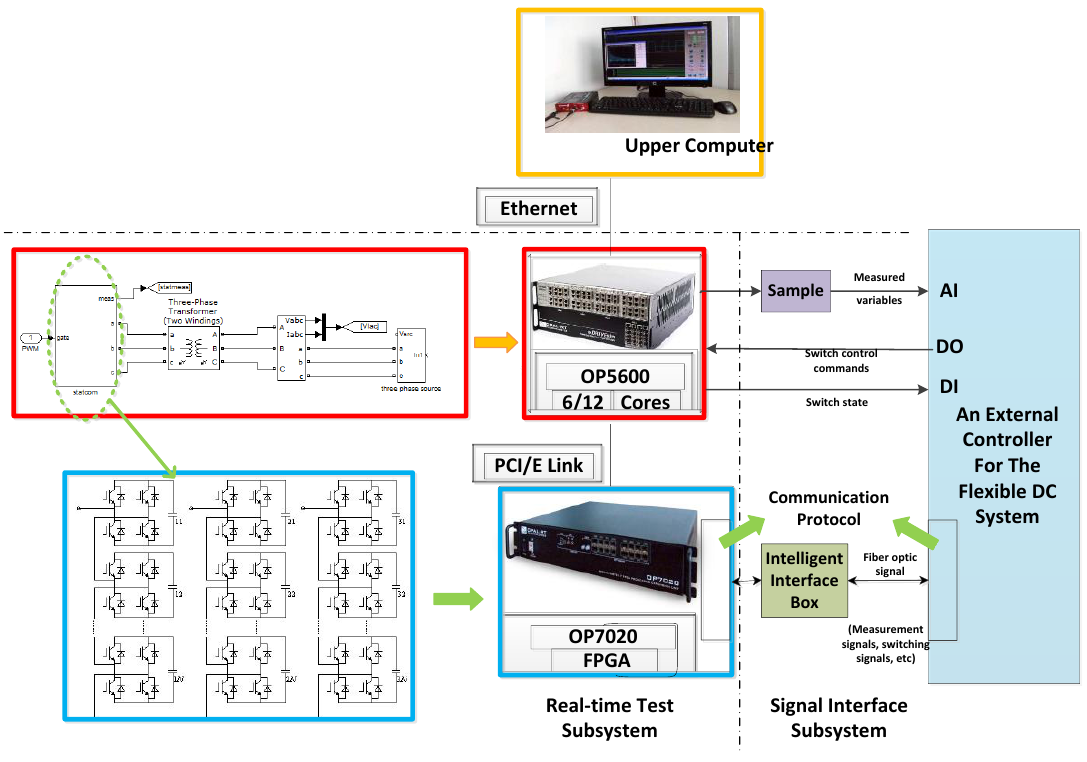
Figure 12. A schematic diagram of the real-time controller hardware-in-the-loop test platform.